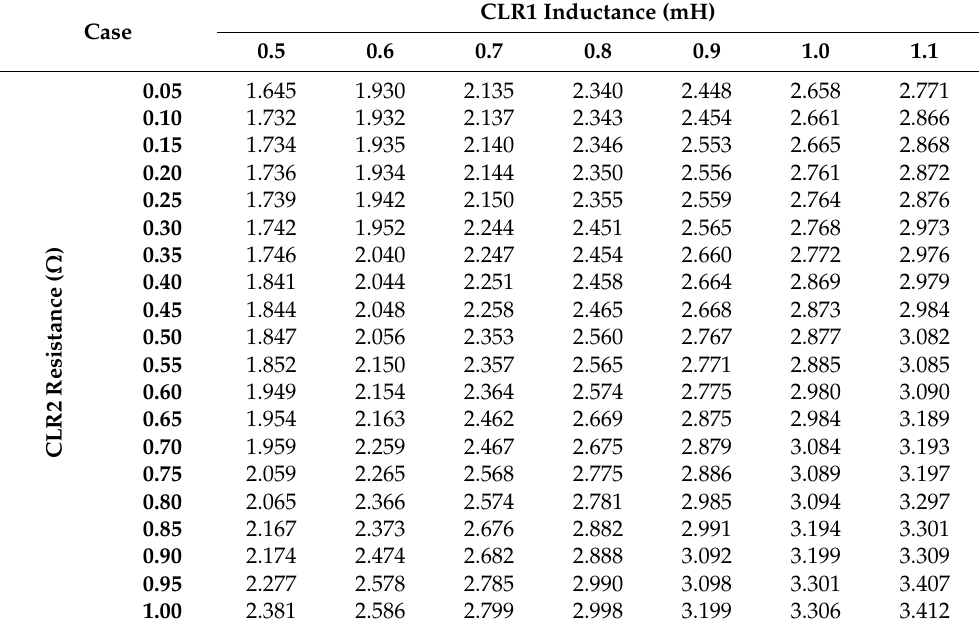
Table 3. Interrupting time